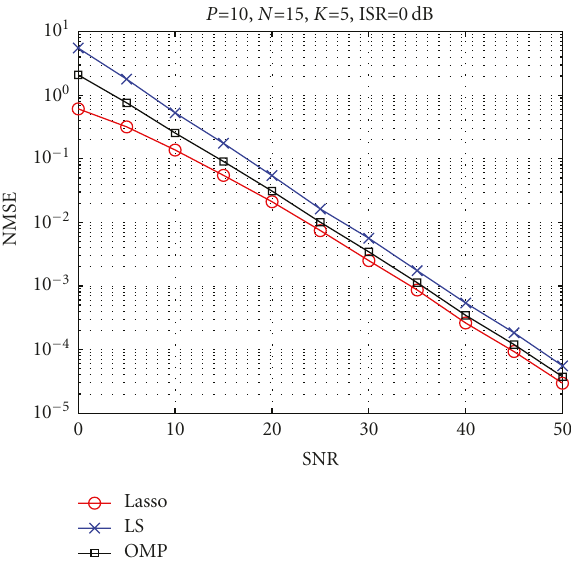
Figure 5: Normalized mean-square error of the composite channel versus SNR for overdeterminate case (asynchronous system with multipath fading channel and known K